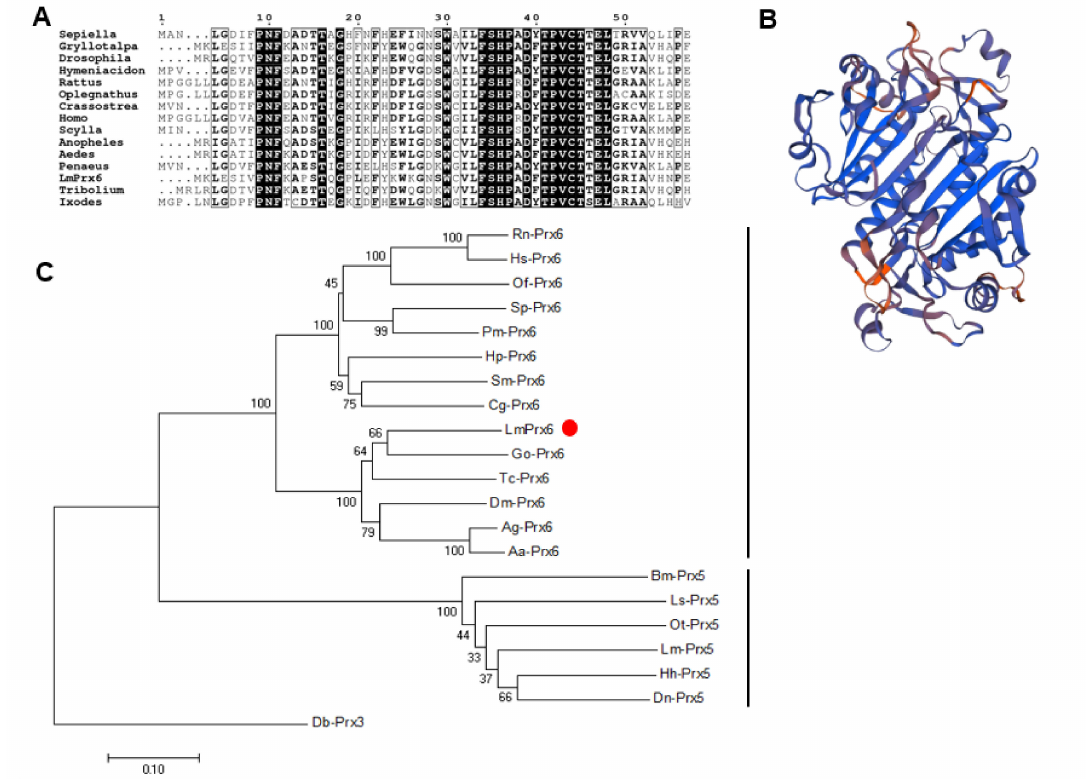
Figure 3. ( A ): Multiple sequence alignment with 15 sequences of PRX6 from di ff erent species; ( B ): the predicted 3-D structure of LmPrx6 with 28.18% α -helix, 19.55% extended strand, 5% β -turn, and 47.27% random coil; ( C ): phylogenetic analysis with 14 sequences of PRX6 from di ff erent species. The tree was generated with MEGA6 after CLUSTAL W alignment using the amino acid